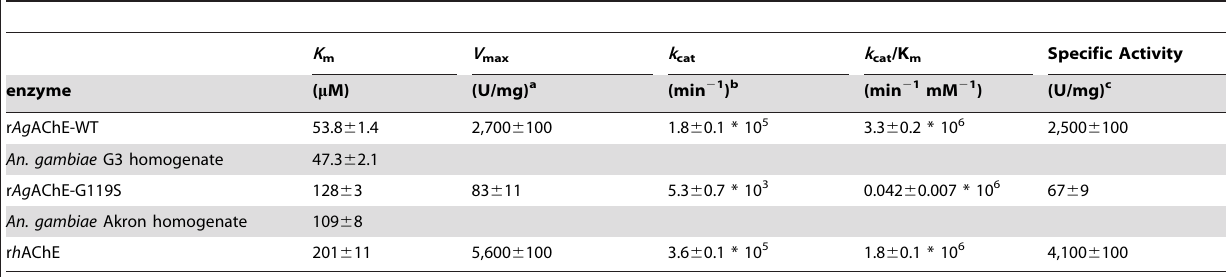
Table 1. Kinetic parameters (23 6 1 u C, pH 7.7) of r Ag AChE (WT & G119S) and r h AChE, and K m values for the ATCh-hydrolyzing enzyme in An. gambiae homogenate (G3 and Akron).